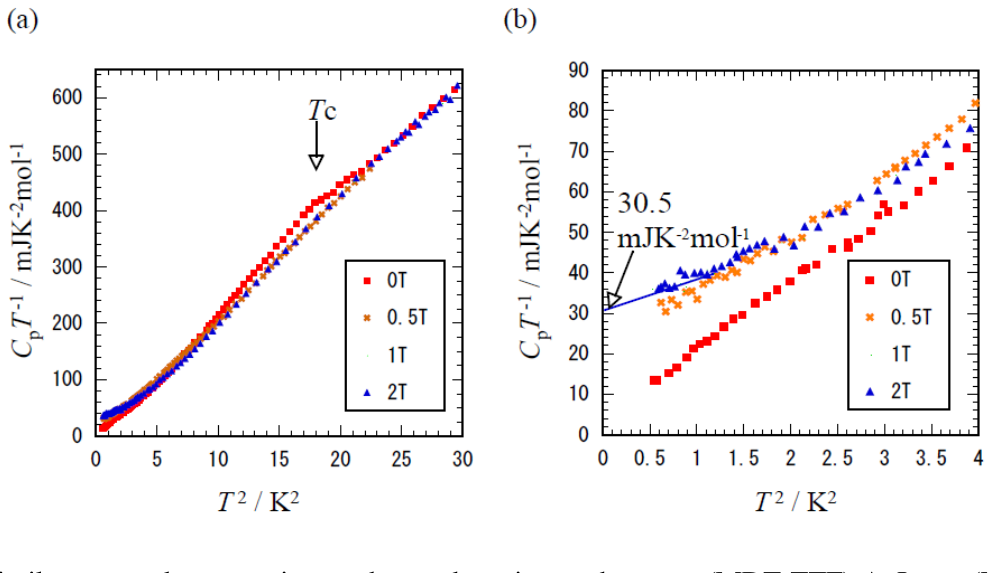
Figure 11. ( a )Temperature dependence of heat capacity of κ -(MDT-TTF) under 0 T, 0.5 T, 1 T and 2 T. ( b ) The extended plot of C temperature